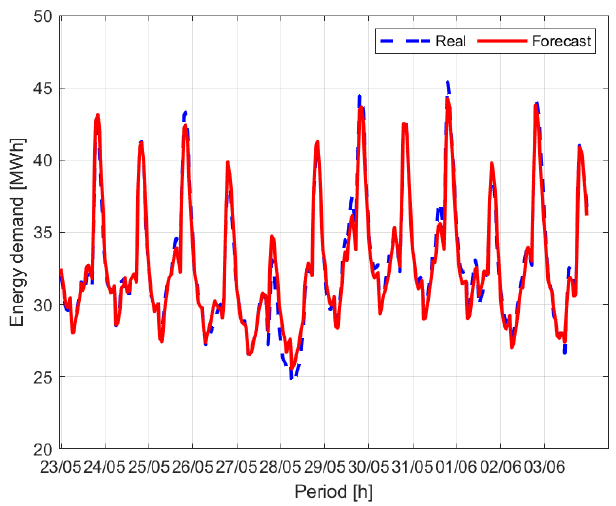
Figure 19. Forecasting energy demand for Market 3.